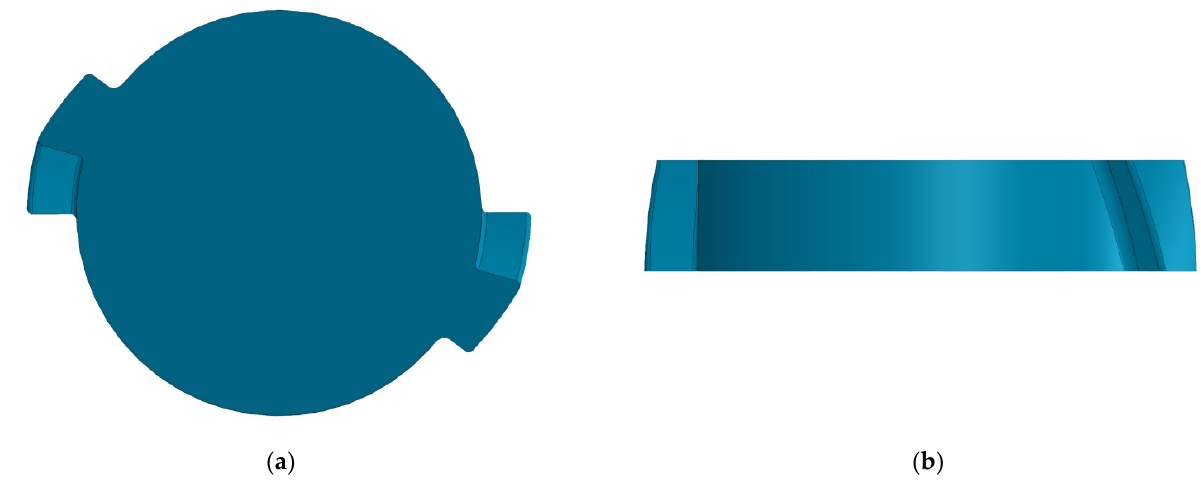
Figure 2. Three-dimensional model of the micro-milling tool. ( a ) End face; ( b ) side.